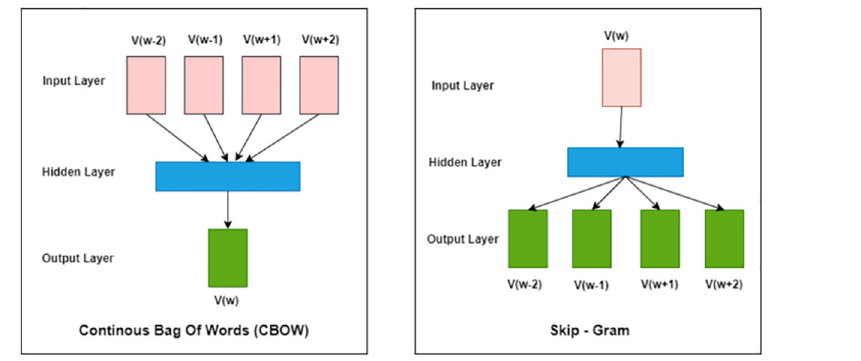
Fig 2. The Word2vec models: CBOW and